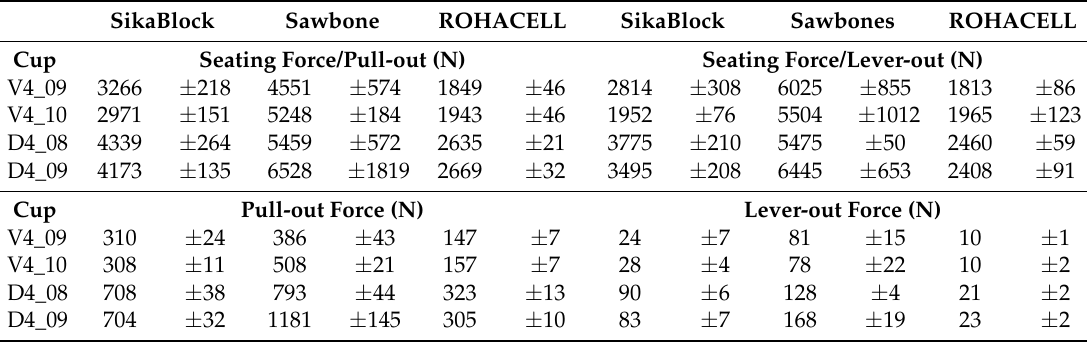
Table 4. Results for the insertion processes in preparation of the pull-out and lever-out tests as well as the forces determined in the tests during the pull-out and lever-out of the cups. The values output as arithmetic mean were determined from n = 5